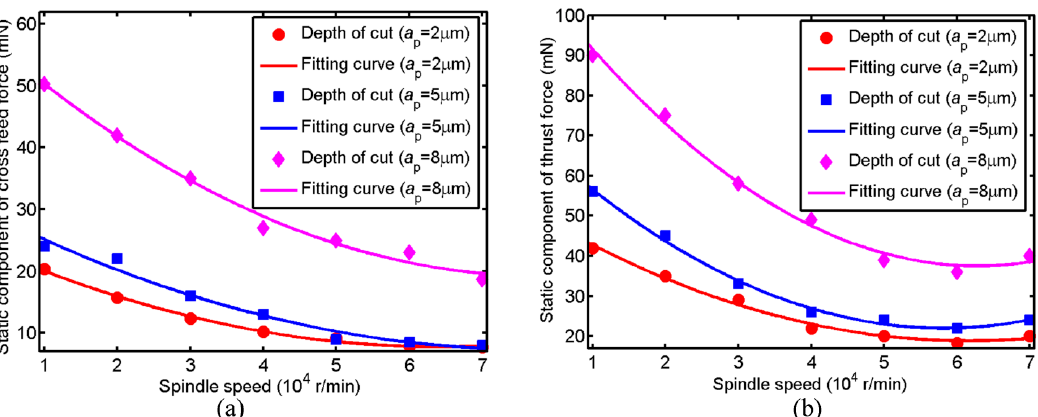
Figure 6. The change of static component of cutting force with spindle speed under different depth of cut ( a ) the static component of cross feed force; ( b ) the static component of thrust force.